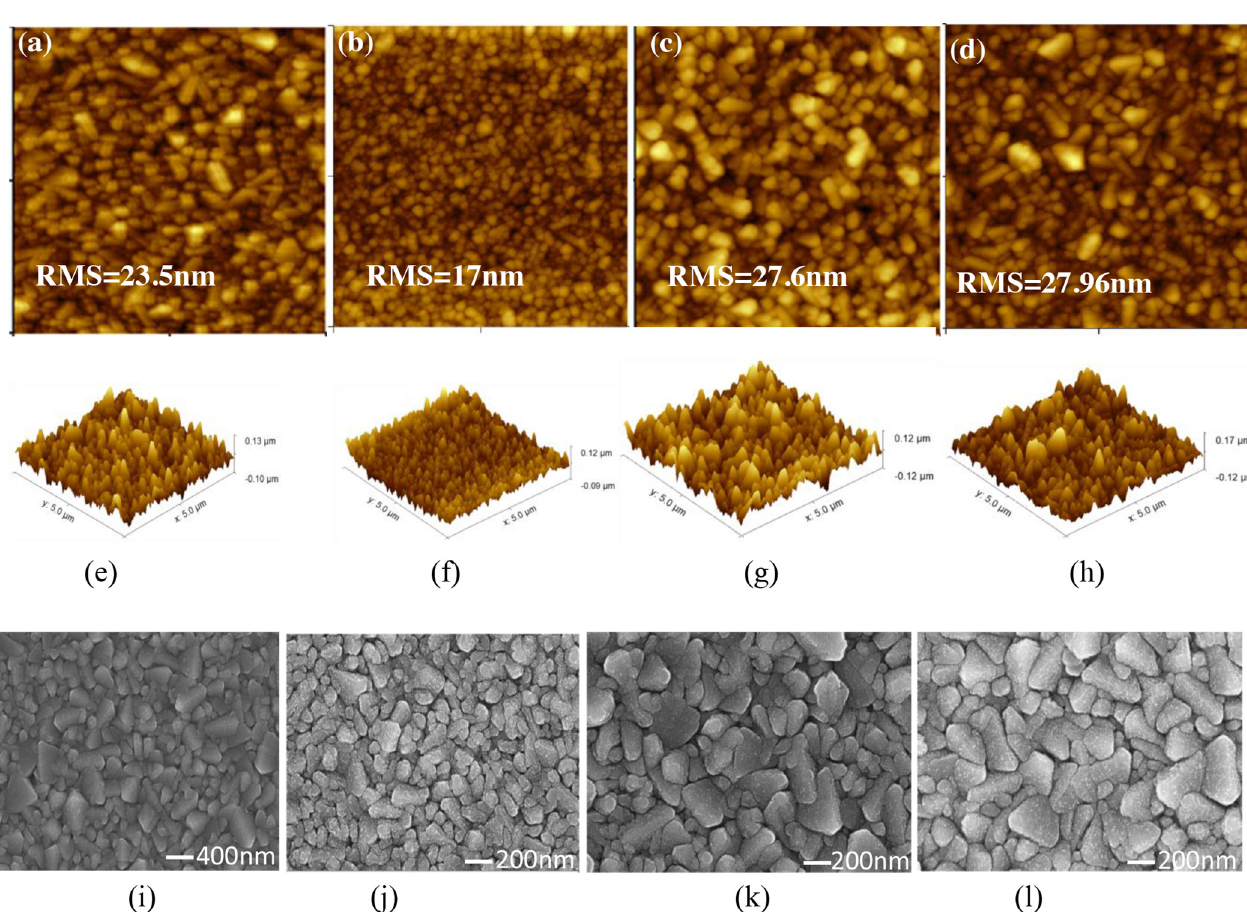
Fig. 3. Surface topographic structure of the compact TiO 2 , so fi lms were grown by DC-sputtering with different powers. Using AFM scanning two and three dimensions for (a,e) 180W, (b, f) 200 W, (c, g) 220W and (d, h) 240W. In addition, showing changing grains size of C-TiO 2 using SEM scanning for (i) 180 W, (j) 200 W, (k) 220W and (l) 240 W. AFM images were 5 (cid:1) 5 m m 2